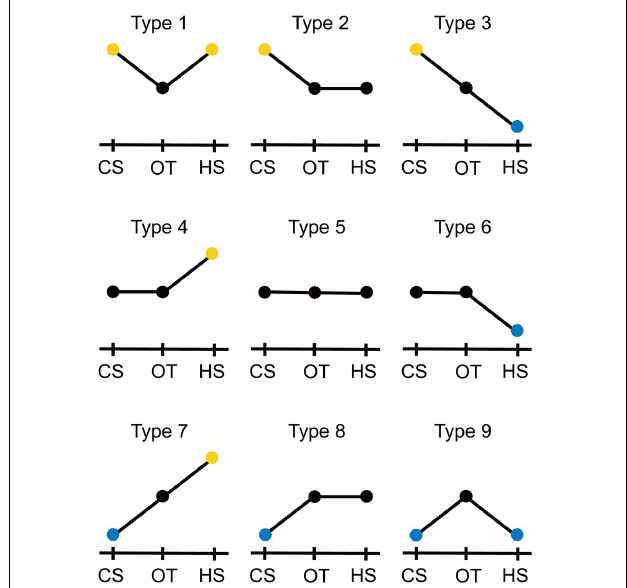
FIGURE 2 | Standard of classification of the unigenes to nine types based on expression trend under cold stress (CS) and heat stress (HS) against optimal temperature (OT). Yellow and blue circles indicate the unigenes upregulated and downregulated, respectively, under CS or HS against OT. Black circles indicate the unigenes under the OT and with unchanged expression under CS or HS against OT. See details in “Materials and Methods”